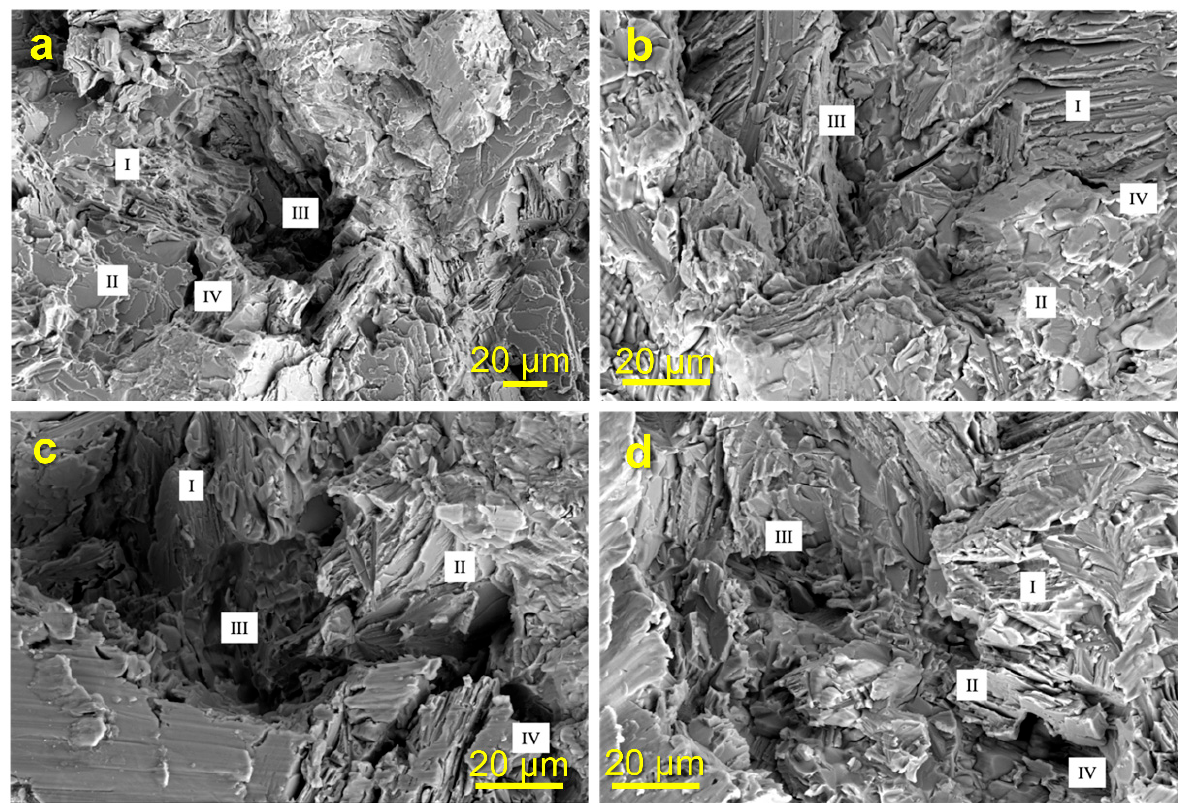
Figure 8. Fracture morphologies of fatigue specimens at 750 ◦ C with the strain amplitude ( a ) 0.44% and ( b ) 0.6% and at 400 ◦ C with the strain amplitude ( c ) 0.44% and ( d ) 0.6%, where I denotes the translemallar fracture, II denotes the interlemallar fracture, III denotes the transgranular fracture, and IV denotes the intergranular fracture.